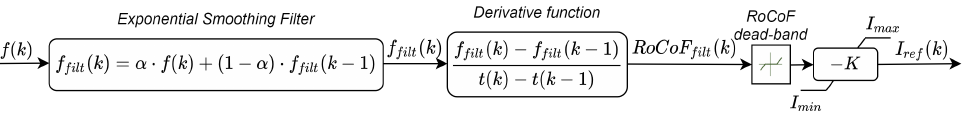
Figure 11. Block diagram of the actual SI controller.